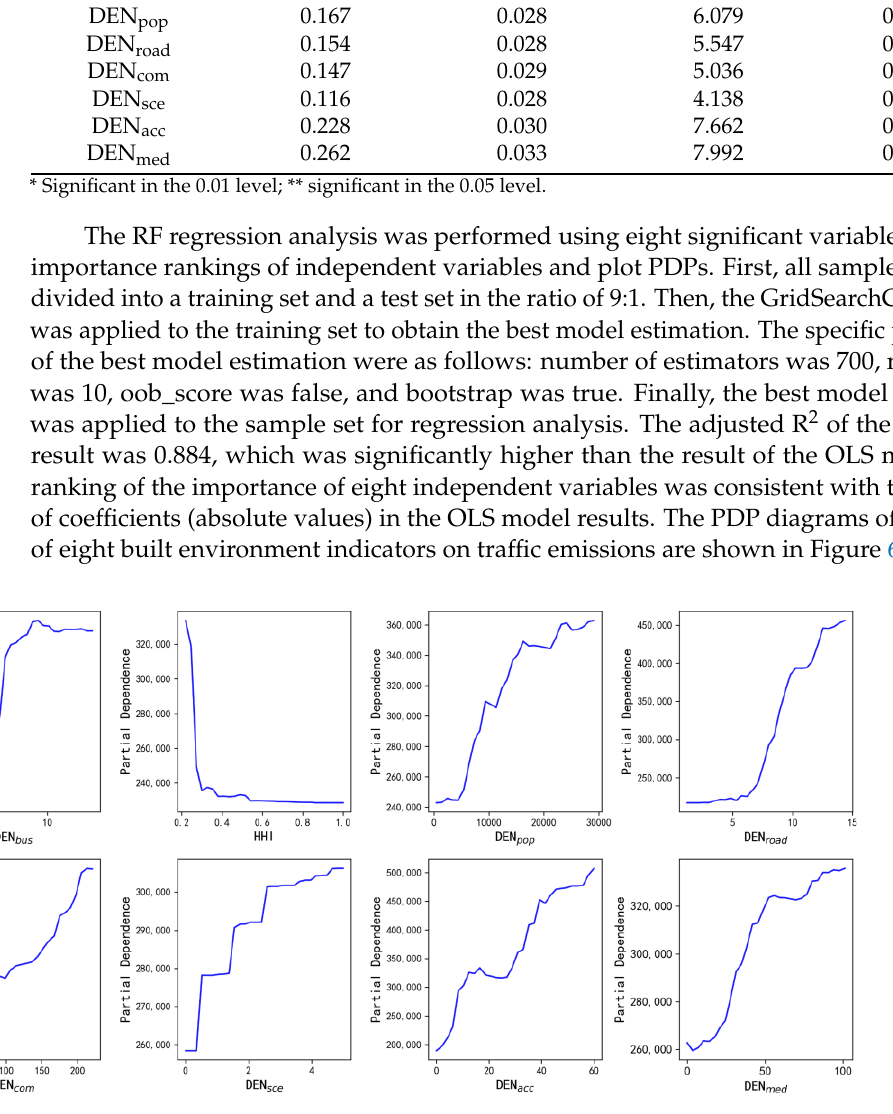
Figure 6. The PDP plots of built environment indicators on taxis emissions.